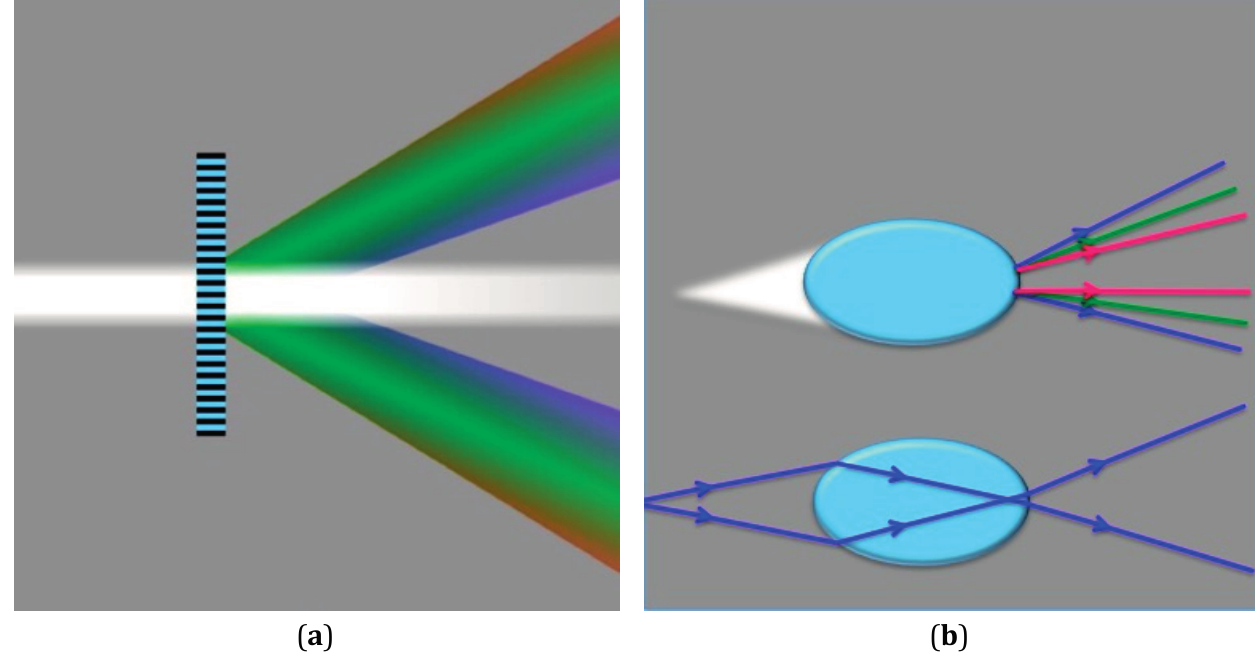
Figure 6. ( a ) The color separation of white light through a diffraction grating film. ( b ) (Top) Chromatic dispersion for a white light point source emitting from a focal zone inside the oblate spheroid due to refraction (color separation exaggerate for clarity) and (bottom) two rays refracting from a blue light source to help clarify that there is a focal zone within the sample chamber. The image in ( a ) was adapted from Cmglee (GFDL (http://www.gnu.org/copyleft/fdl.html)), via Wikimedia Commons, in order to provide a visual reference to compare with the chromatic dispersion effect shown in ( b